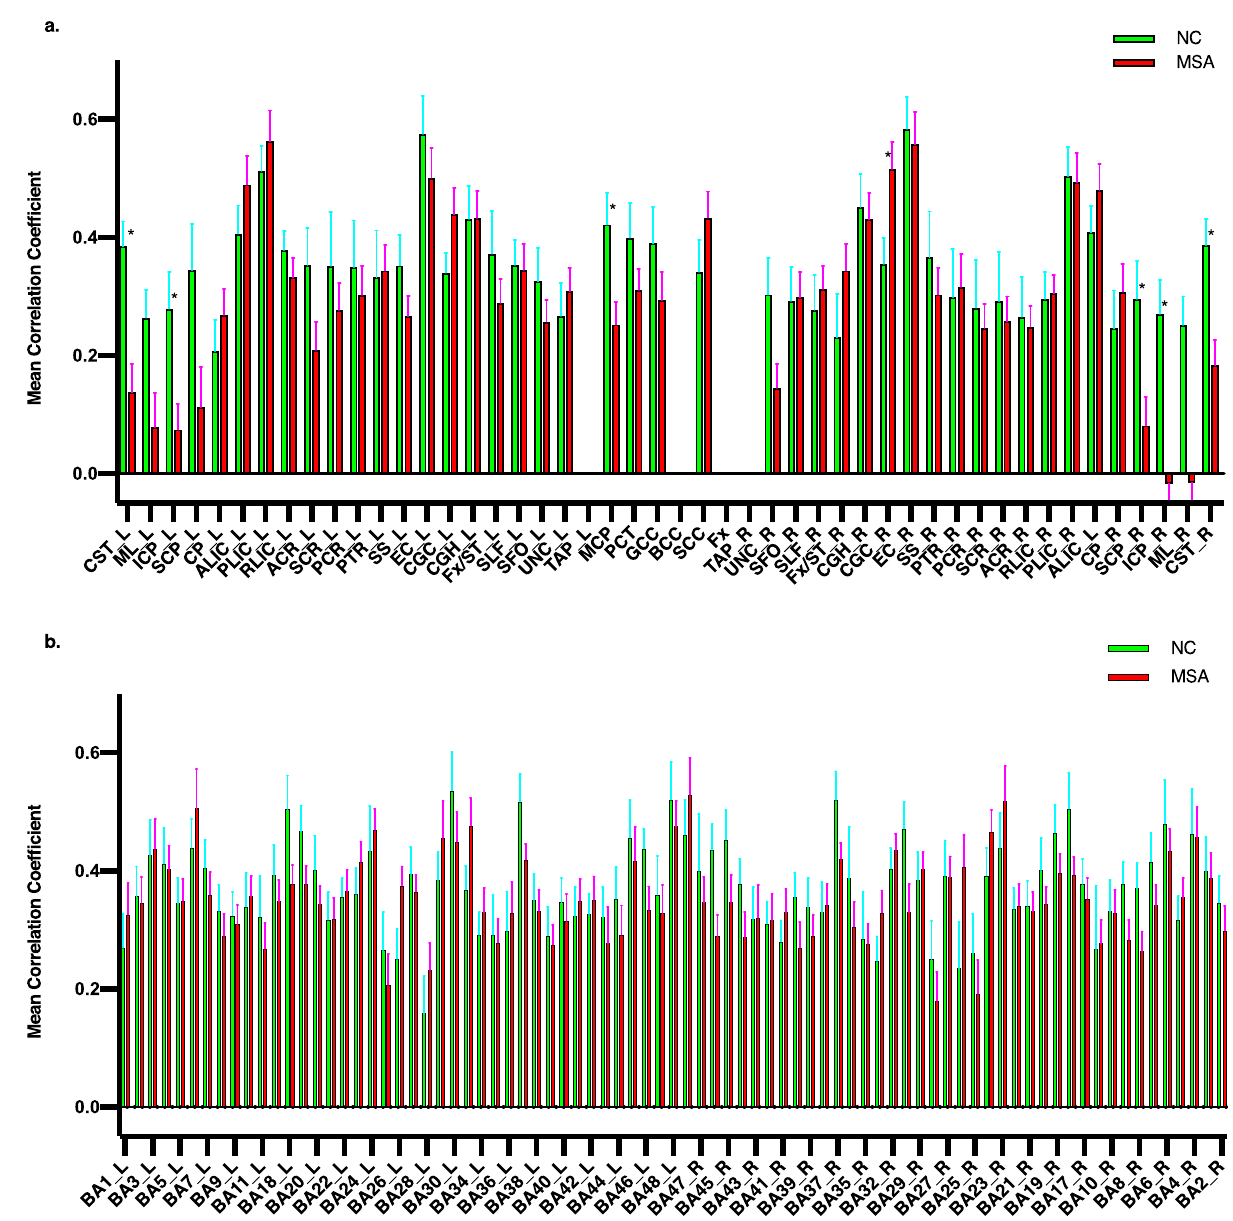
Fig. 2 Comparisons of temporal correlations of white matter and gray matter fMRI signals between normal controls and MSA-C patients. Comparisons of averaged temporal correlations of WM bundles ( a ) and the GM region ( b ) between the control (green) and disease (red) groups. Mean and standard error are shown, with signi fi cant differences ( P < 0.05, corrected) marked with asterisks